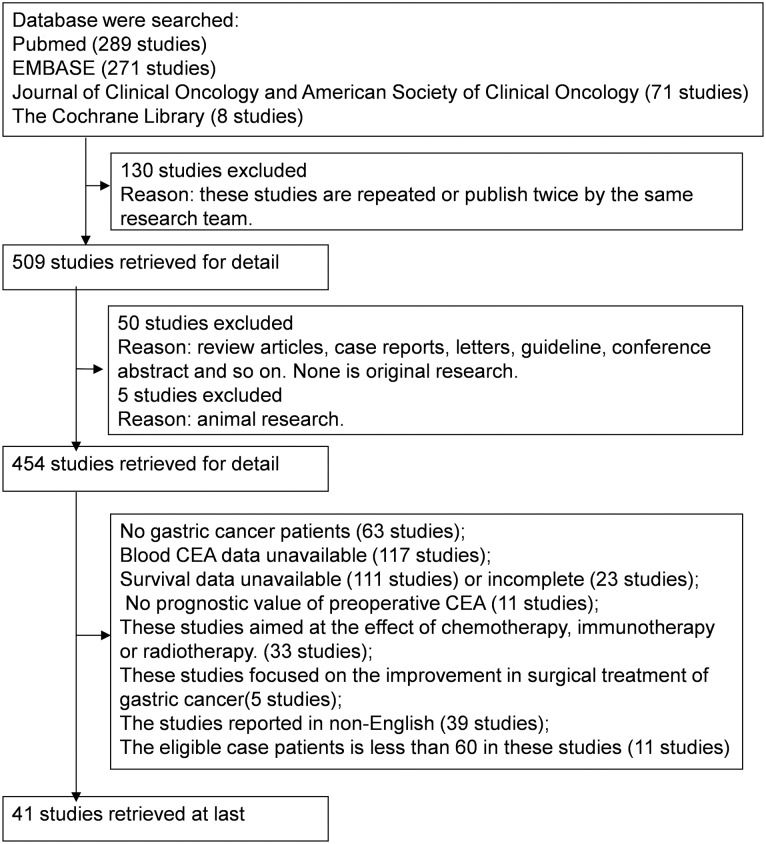
Flow chart of the meta-analysis.